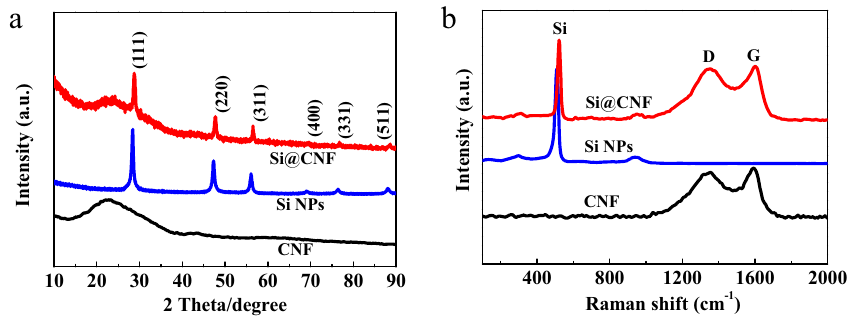
Figure 3: ( a ) XRD patterns and ( b ) Raman